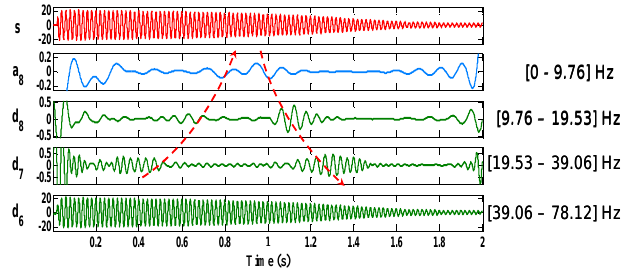
Fig. 8. 8-level DWT of the startup current for the unloaded machine with one broken bar.